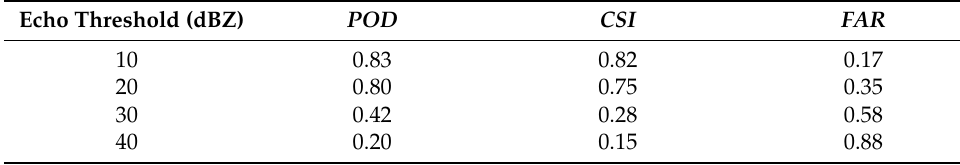
Table 3. CTREC algorithm extrapolation results at 1 h.